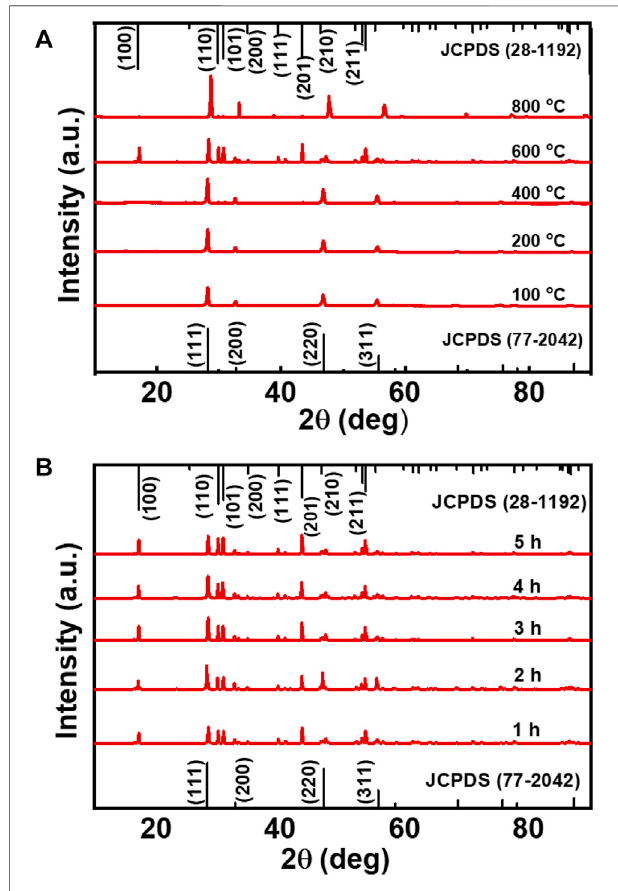
FIGURE 4 | (A) XRD spectra of NaYF 4 :Yb/Er UCNPs synthesized at varying reaction temperature (reaction carried out for a period of 3 h), and (B) at different reaction time (reaction carried out at a temperature of 600 °